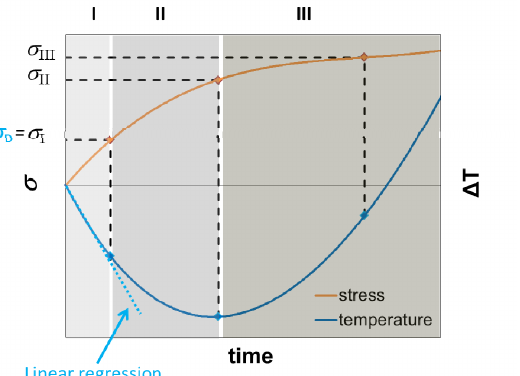
Figure 5: Schematic representation of stress and temperature trends and the three temperature regions, highlighetd with grayscale colors. In region I, the temperature data are fitted with a line, allowing the determination of the damage stress, σ , the first stress level used in the interrupted static tests. In the graph, also σ to σ I the minimum temperature and to the end of region II, and the latter corresponding to the increasing temperature region (i.e. region III). Also, σ and σ are used as stress levels for the interrupted static II III